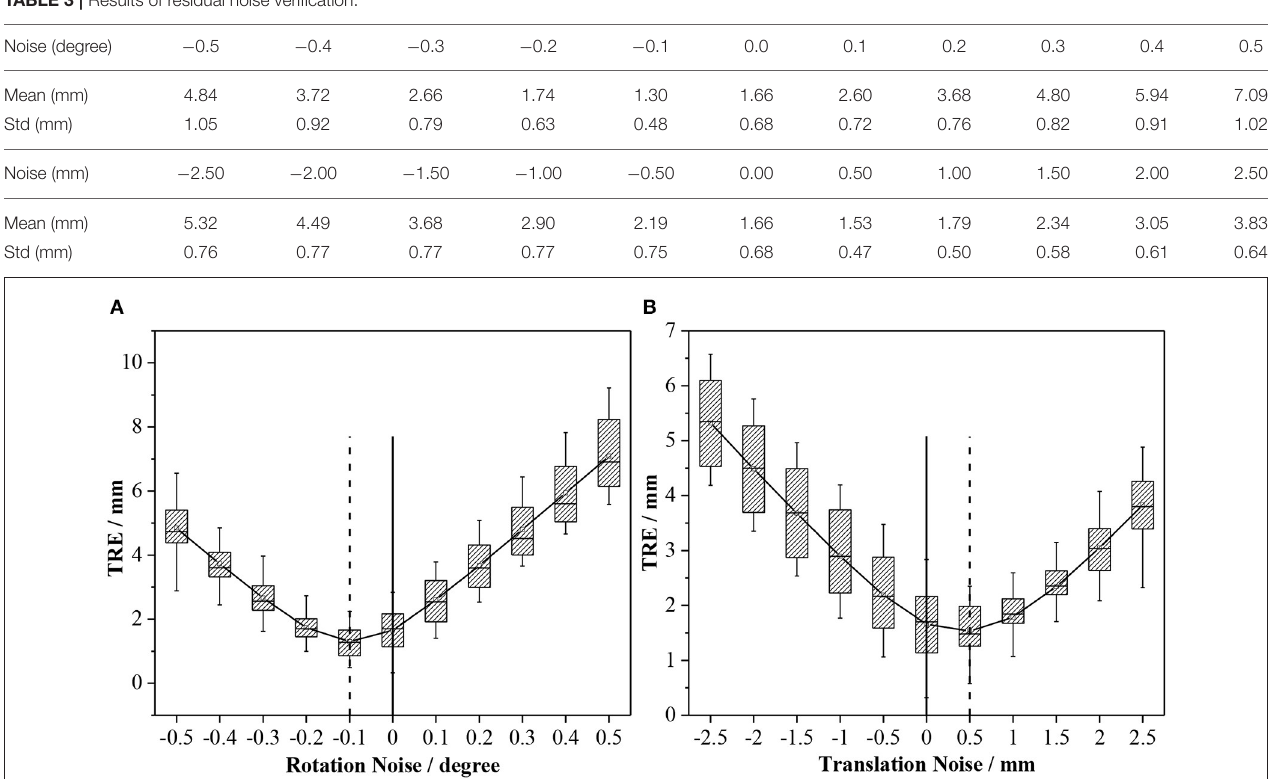
TABLE 3 | Results of residual noise verification.